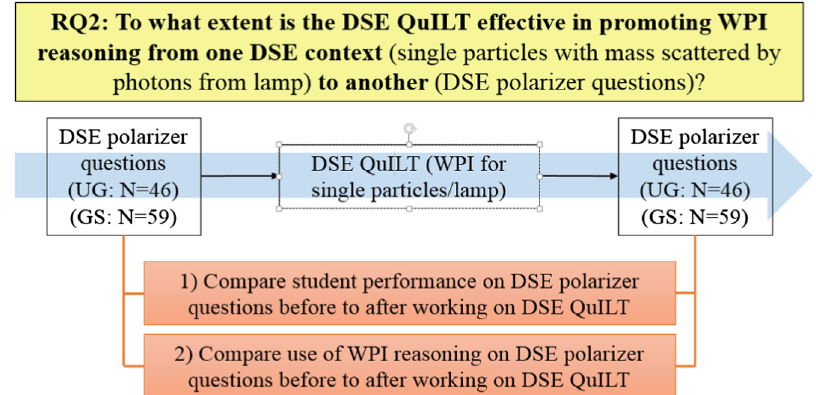
FIG. 2. Schematic description of the design used to investigate RQ2. UG, GS, and N have the same meaning as in Fig. 1. The timeline of chronological order is from left to right as depicted by the blue